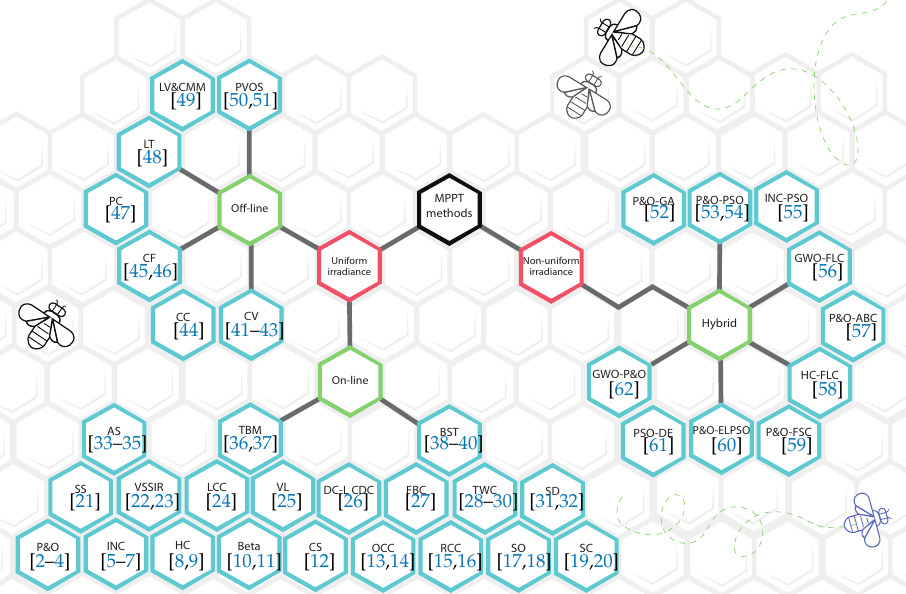
Figure 1. A classification of MPPT techniques (please see the abbreviation section for the full name of each